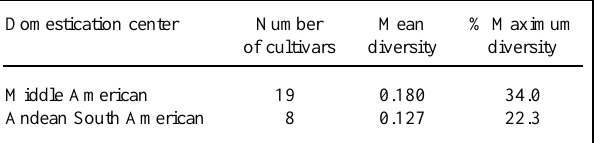
Table III - RAPD marker diversity of common bean cultivars within domestication